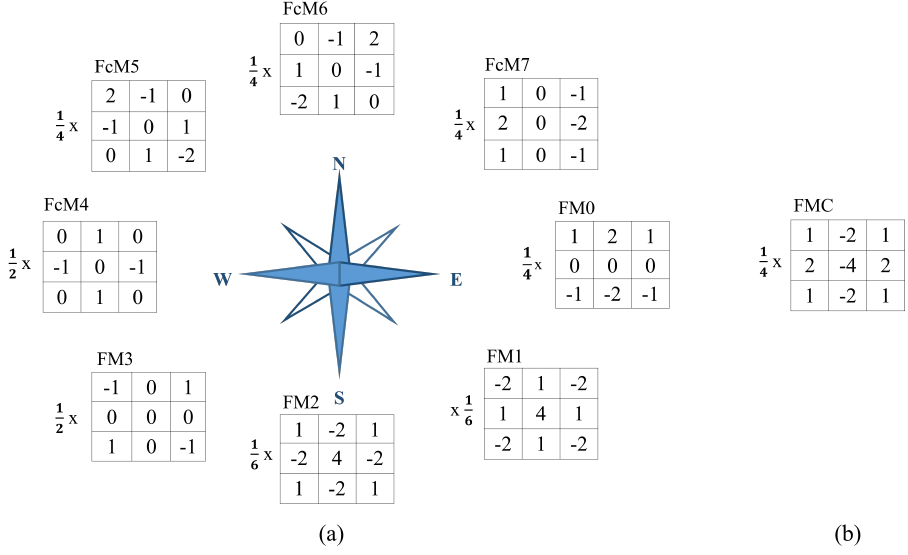
Figure 4. ( a ) Modified Frei–Chen masks in eight directions; ( b ) 2nd derivative of the Gaussian